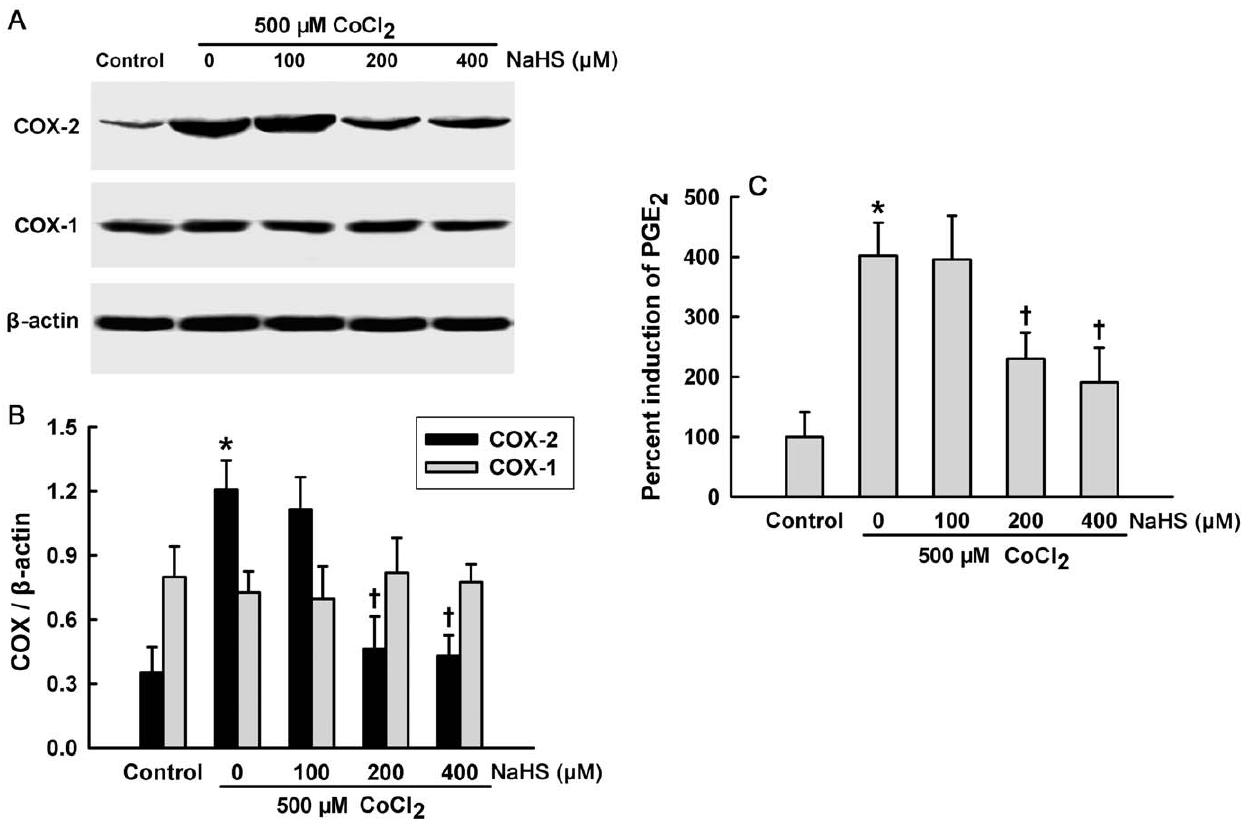
Figure 4. Effect of H 2 S on CoCl 2 -induced COX-2/PGE 2 overexpression. HaCaT cells were incubated with 500 m M CoCl 2 for 6 h in the absence or presence of pretreatment with NaHS at the indicated concentrations for 30 min. ( A ) Cell lysates were subjected to Western blot analysis using COX-2- or COX-1-specific antibody. ( B ) The intensity of the protein bands of a typical experiment was quantified with Image J 1.41o software. ( C ) PGE 2 level in cell supernatants was measured by ELISA. Data were shown as the mean 6 SE. * P , 0.01 compared with control group. + P , 0.01 compared with CoCl 2 treatment group. cells. This enhancement peaked at 2 h (Figure 6 A and B), indicating that CoCl 2 exposure may evoke NF- k B activation.